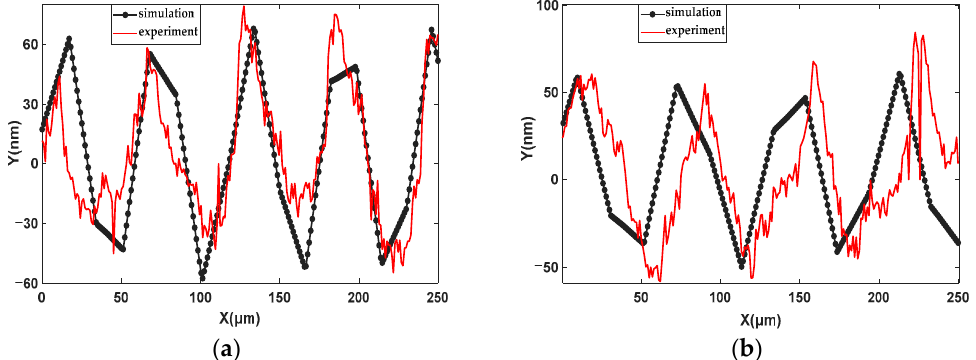
Figure 10. Comparison between the surface profiles of simulation results and experiment surfaces: ( a ) results with ap = 9 μ m, n = 1300 r/min, and f = 12 μ m/r; ( b ) results with ap = 6 μ m, n = 1400 r/min, and f = 14 μ m/r.